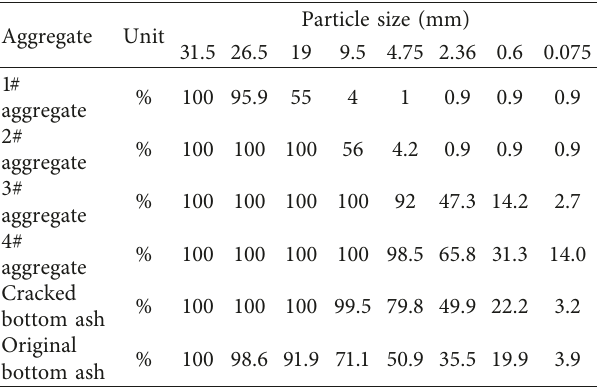
Figure 1: Examples of bottom ash. (a) Original bottom ash. (b) Cracked bottom ash. Table 1: Particle size distribution of 1#, 2#, 3#, and 4# aggregates, original bottom, and cracked bottom ash